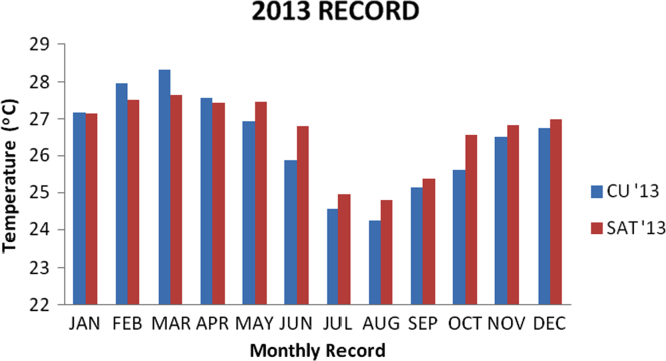
Chart for 2013 data.